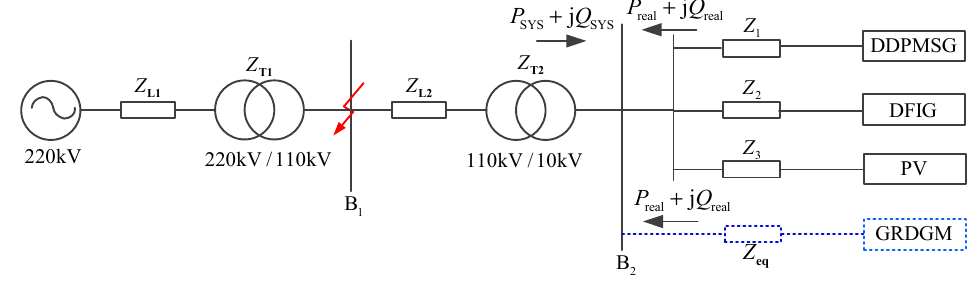
Figure 5. Grid-connected diagram of the three DGs.